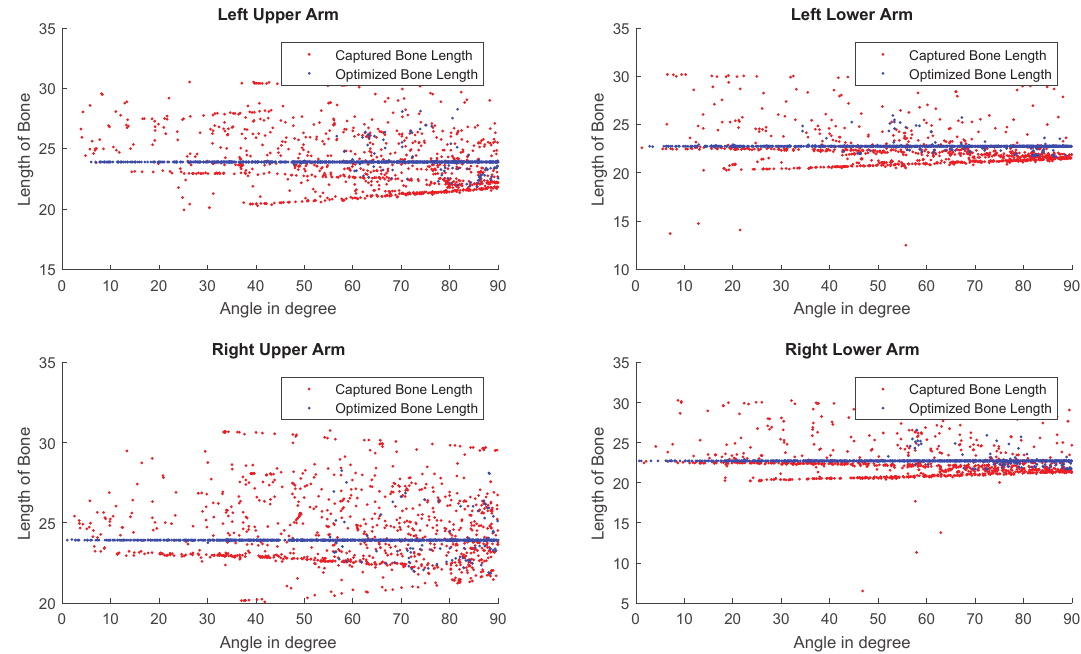
Figure 10. The bone length estimation of four different sections in the skeleton of a motion clip shown respectively in four diagrams. Red: The bone length estimated from the skeleton observed by Kinect SDK [1]. Blue: The bone length estimated via our